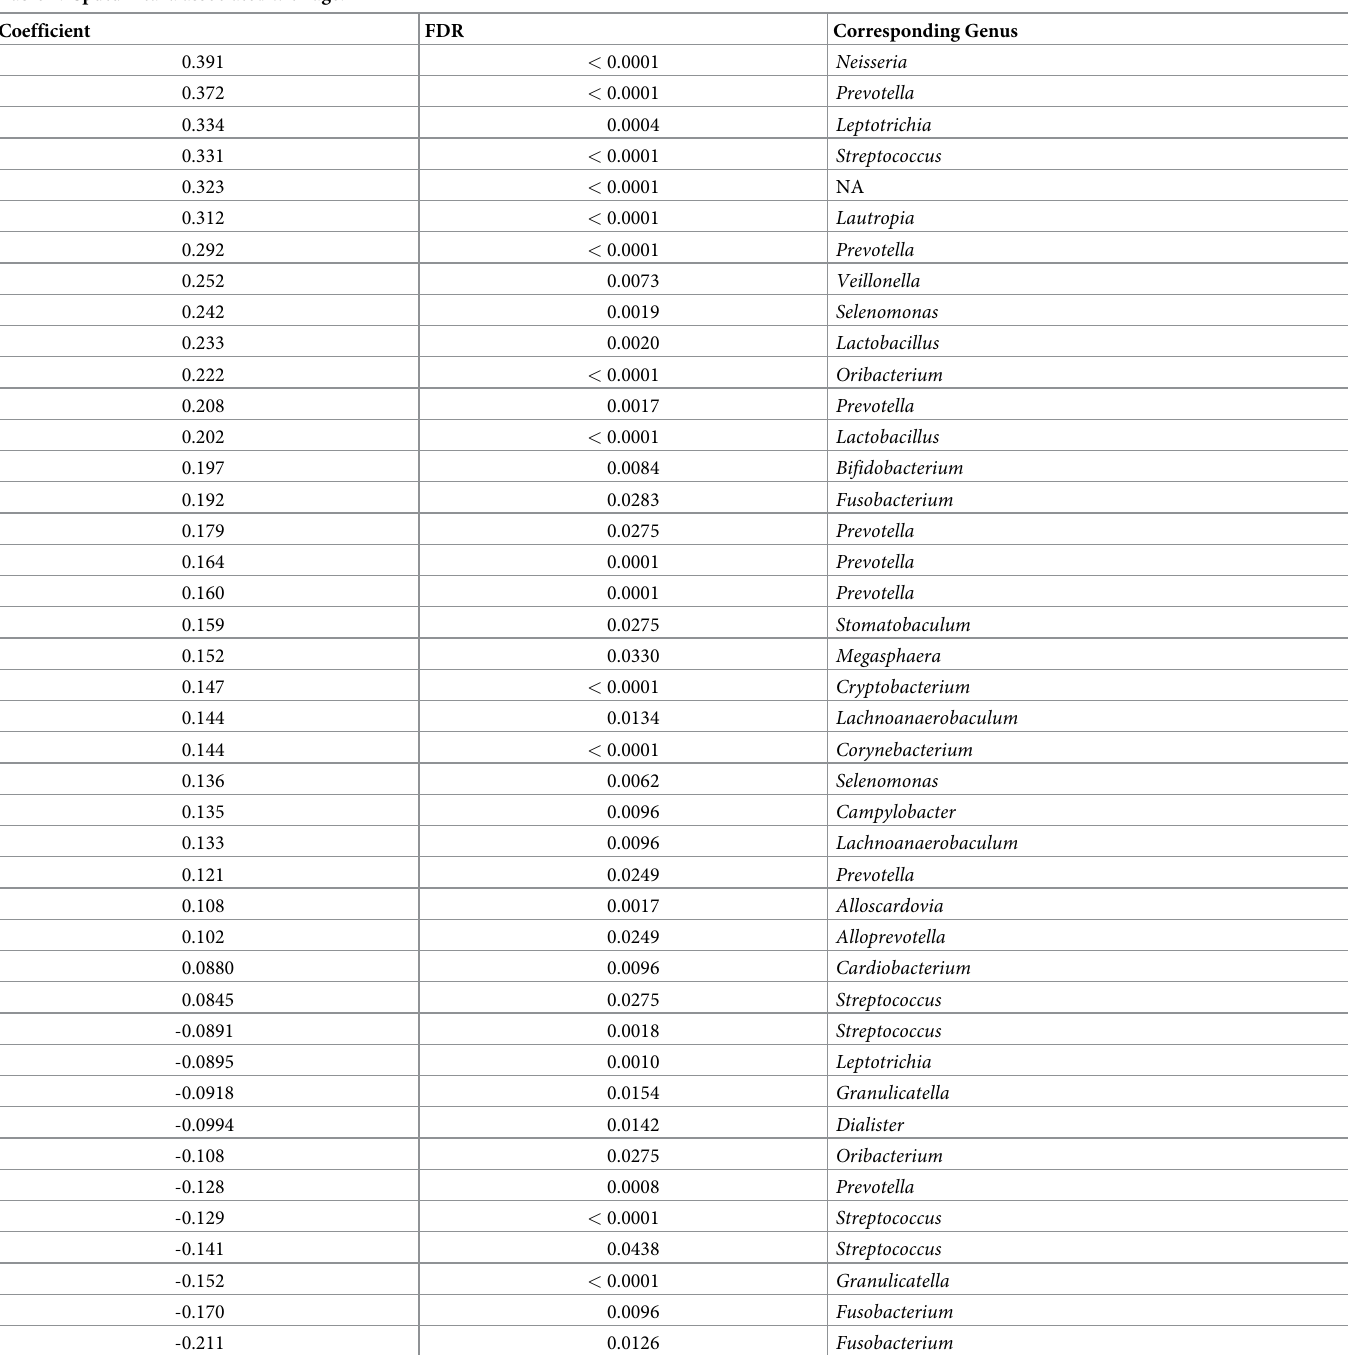
Table 4. Sputum taxa associated with